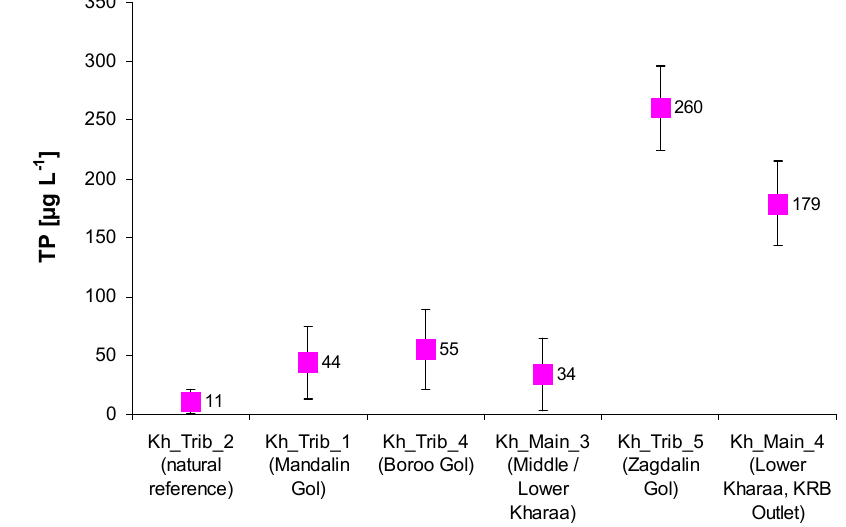
Figure 4. Concentrations of total phosphorus (TP; n = 124) in (µg·L − 1 ) given as mean values and standard deviations in surface water bodies of KRB for the monitoring period 2007 to 2011. The diagram is arranged from the water towers with natural reference conditions in Khentii Mountains downstream to the KRB outlet. The highest concentrations were measured in Zagdalin Gol. Water body codes after